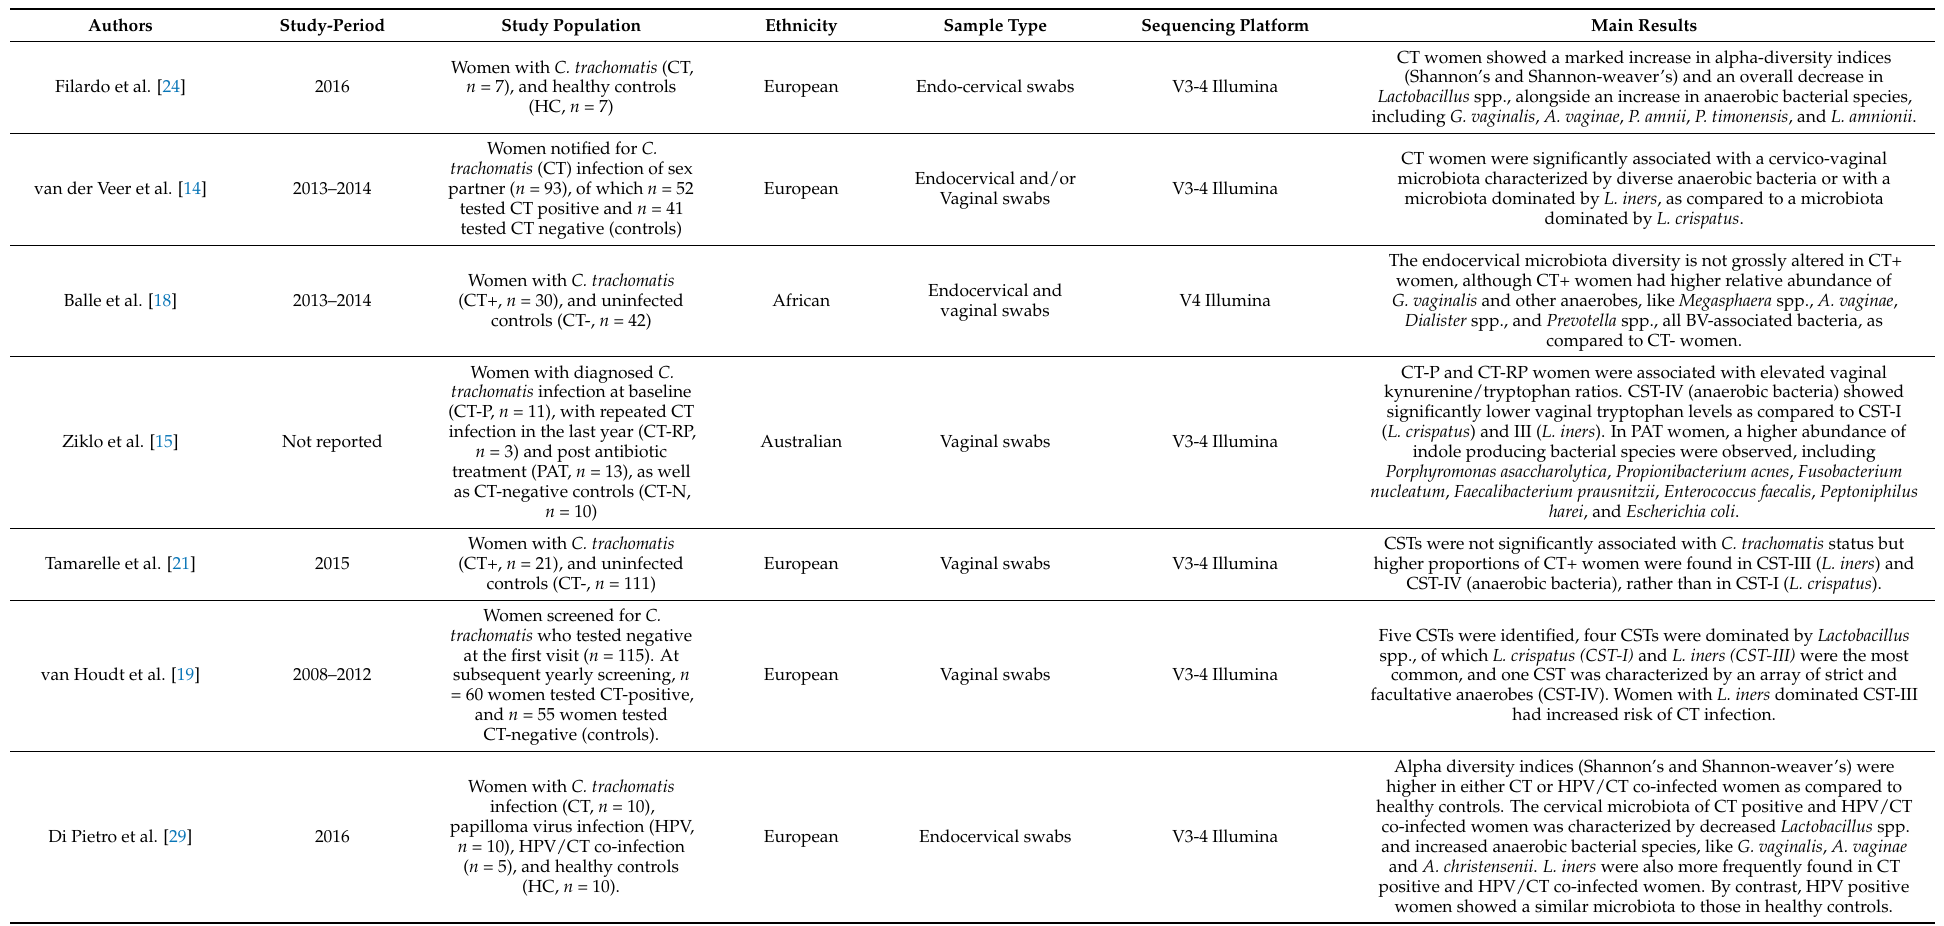
Table 1. Characteristics of the studies ( n = 16) included in the systematic